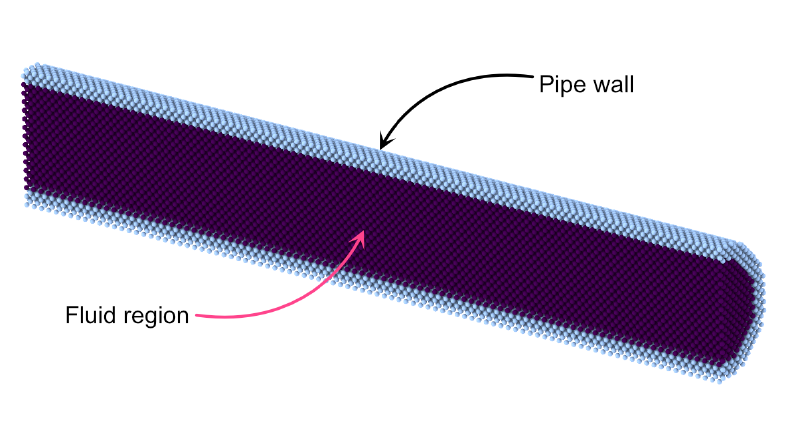
Figure 20. Pipe geometry for the small scale simulations.